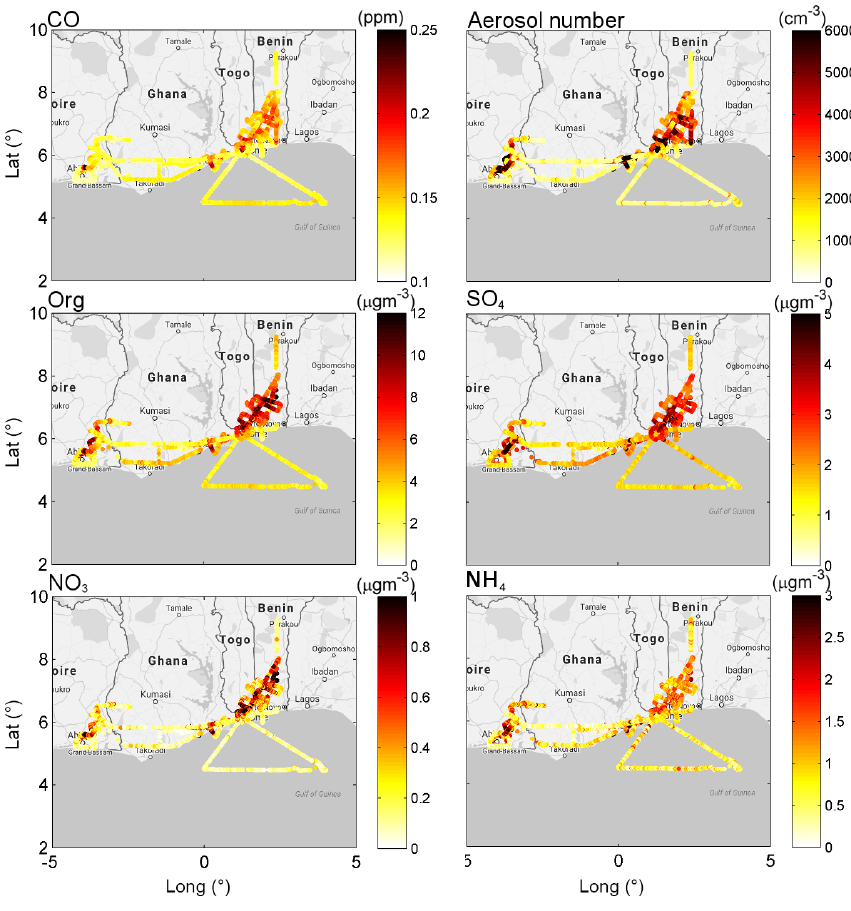
Figure 2. Spatial distribution of CO, aerosol number concentration, OA, SO 4 , NO 3 and NH 4 for flight trajectories below 2000m.